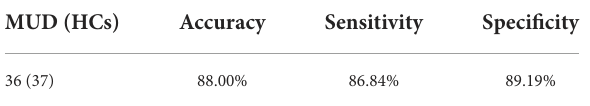
TABLE 2 Prediction performance of support vector machine (SVM) classifier trained on resting state functional magnetic resonance imaging (rs-fMRI) data.